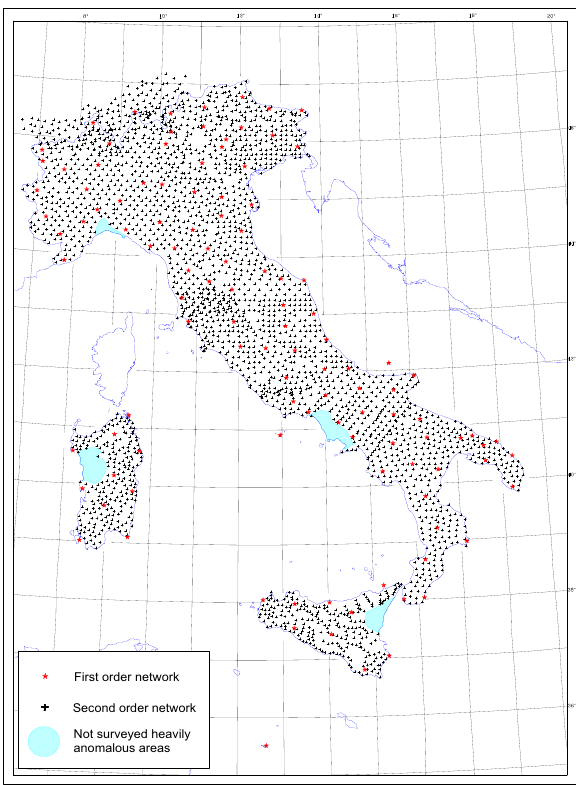
Figure 1. Italian magnetic measurements network. Red stars refer to first order network (repeat stations) while black crosses refer to the second order network points, as undertaken by PFG-CNR for el- ements F , H and Z . All second order network data points were meas- ured between 1977-1981, while only first order network points are repeated every five years for secular variation